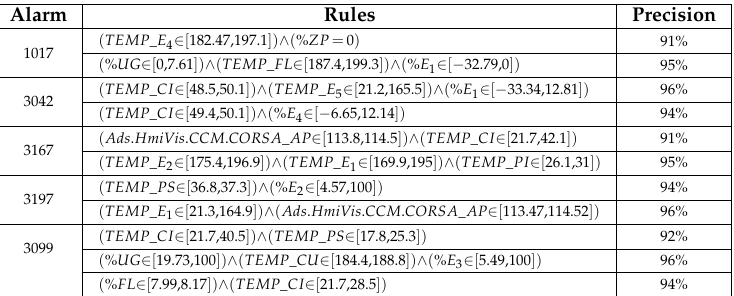
Table 7. Relaxed Separate-and-Conquer (RSC) (RUL = 120 s).